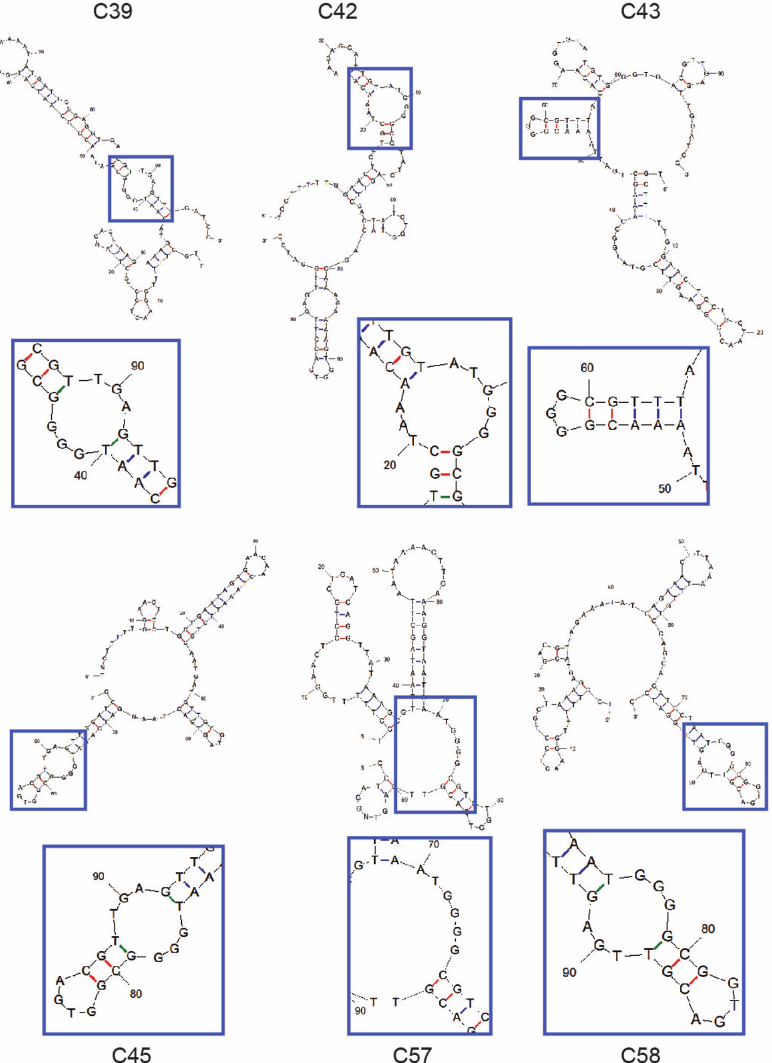
Figure 2 Structure of six Panc-02-selected DeNAno clones. mFold folding of selected DeNAno clones at 4 ° C. A representative structure is shown when output showed more than one potential structure. The GGGG of the sequence motif is unpaired in all the clones (highlighted in blue